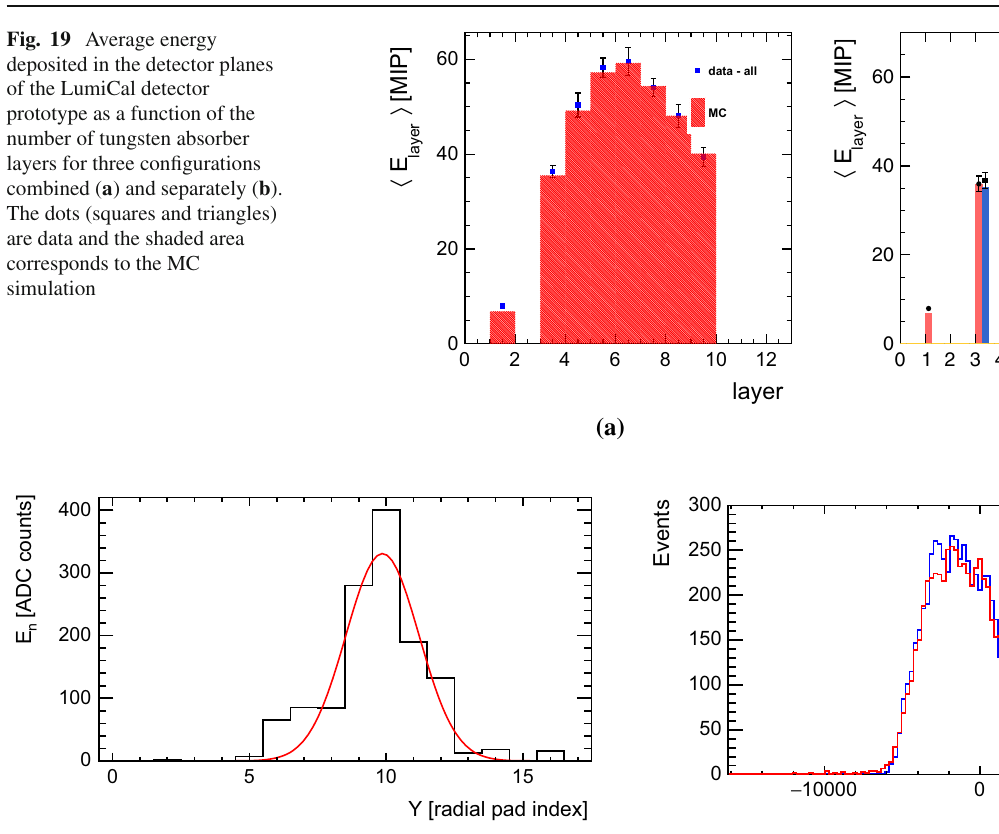
Fig. 21 The distribution of the radial shower position Y (red line) and the radial hit position reconstructed from the beam Telescope data (blue line). The two distributions are shifted to appear one on top of the other for comparison